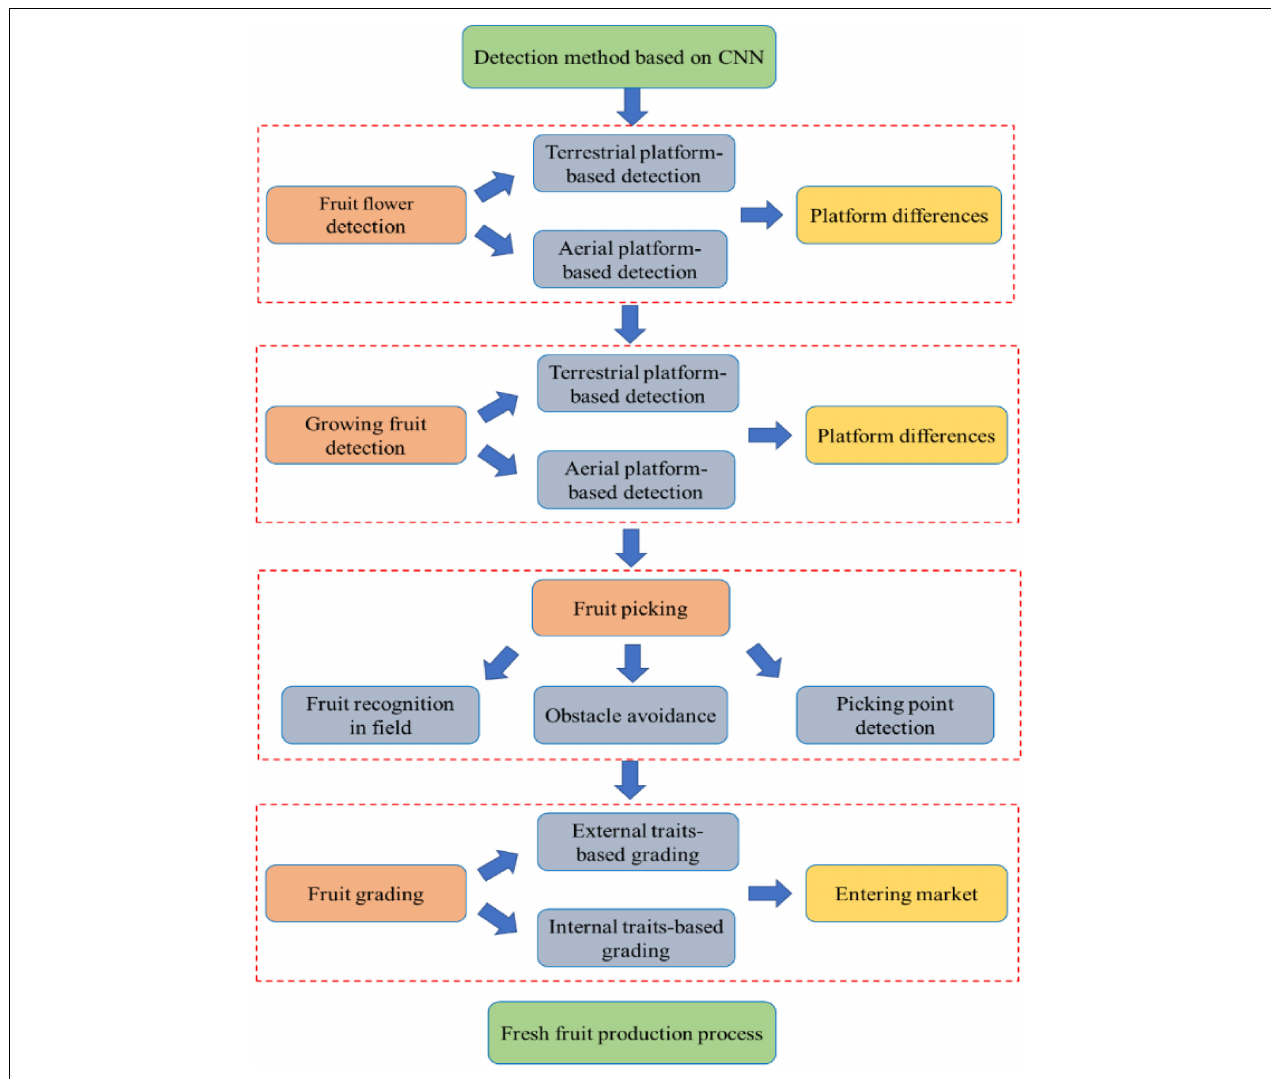
FIGURE 1 | Convolutional neural network (CNN)-based detection application in main links of fresh fruit